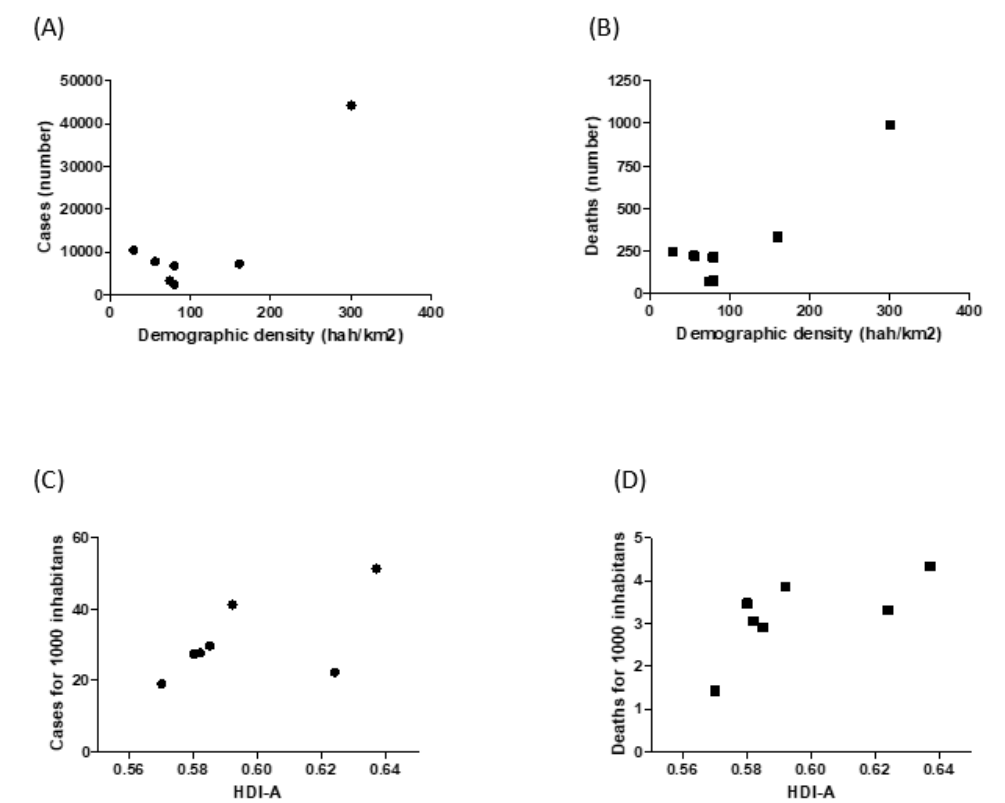
Figure 2. Cumulative data about COVID-19 by health regions of the State of Sergipe, Brazil, from April to October 2020. ( A ) Relationship between demographic density and confirmed COVID-19 cases; ( B ) relationship between demographic density and deaths by COVID-19; ( C ) relationship between COVID-19 case incidence and Human Development Index—average (HDI-A); ( D ) relationship between COVID-19 death incidence and Human Development Index—average (HDI-A).